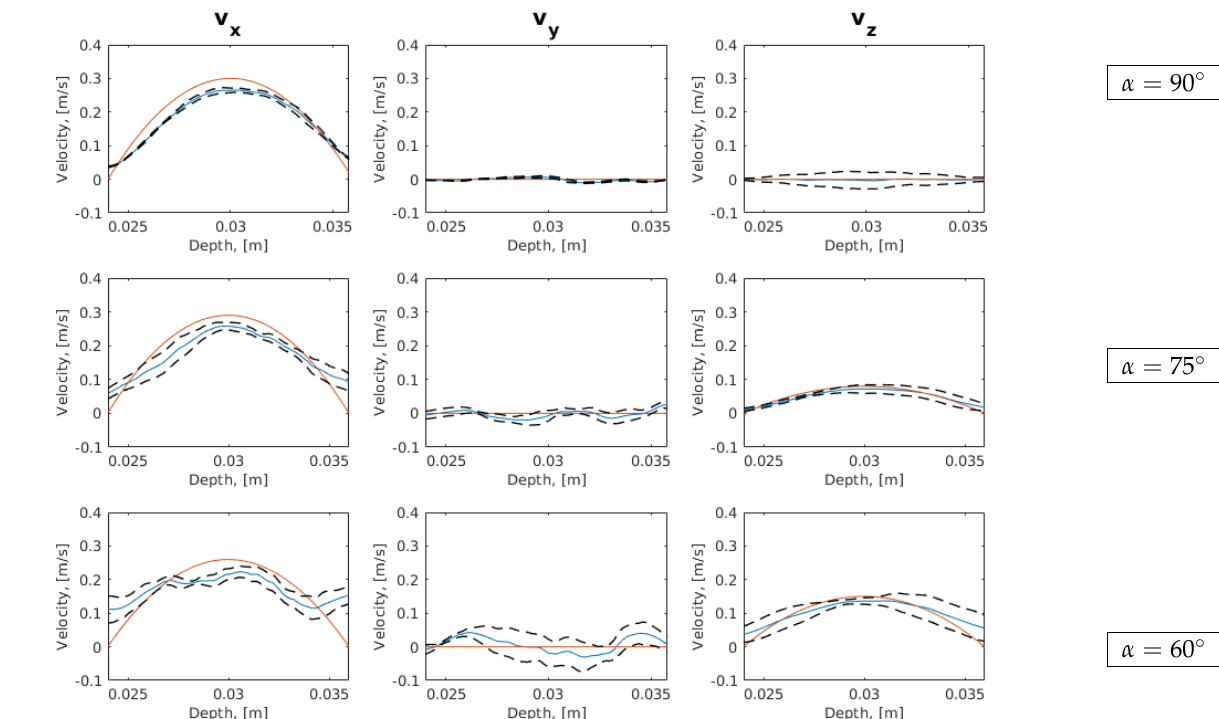
Figure 4. Estimated center profiles from simulated data for α = ( 60,75,90 ) ◦ , β = 0 ◦ . Standard settings from Table 1 were used. The red line is theoretical profile, the blue curve is estimated mean profile, the dashed black curves are the relative standard deviation.